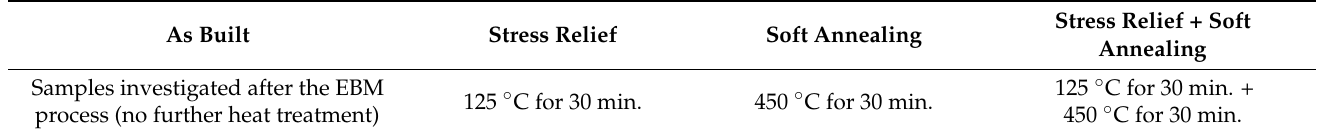
Table 1. Heat treatments of EBM Cu samples.